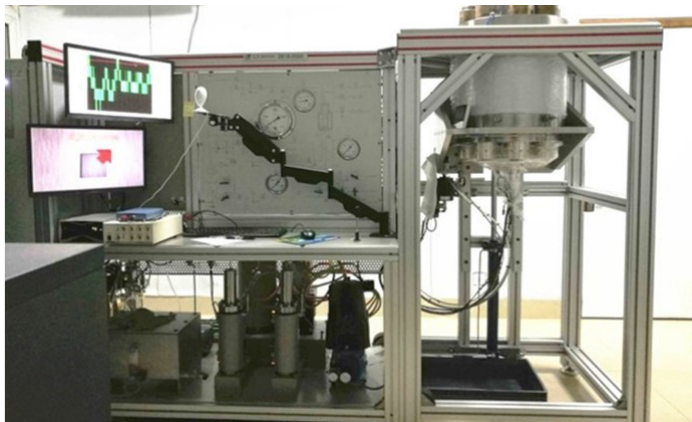
Figure 1. Servo-controlled rock triaxial testing